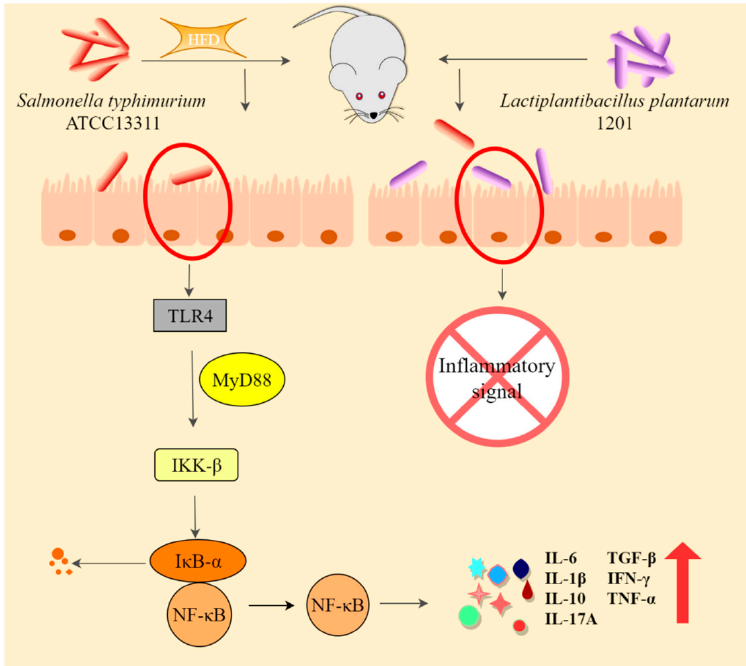
Figure 6. HFD exacerbates the intestinal infection of S. Typhimurium ATCC 13311, while L. plantarum 1201 inhibits